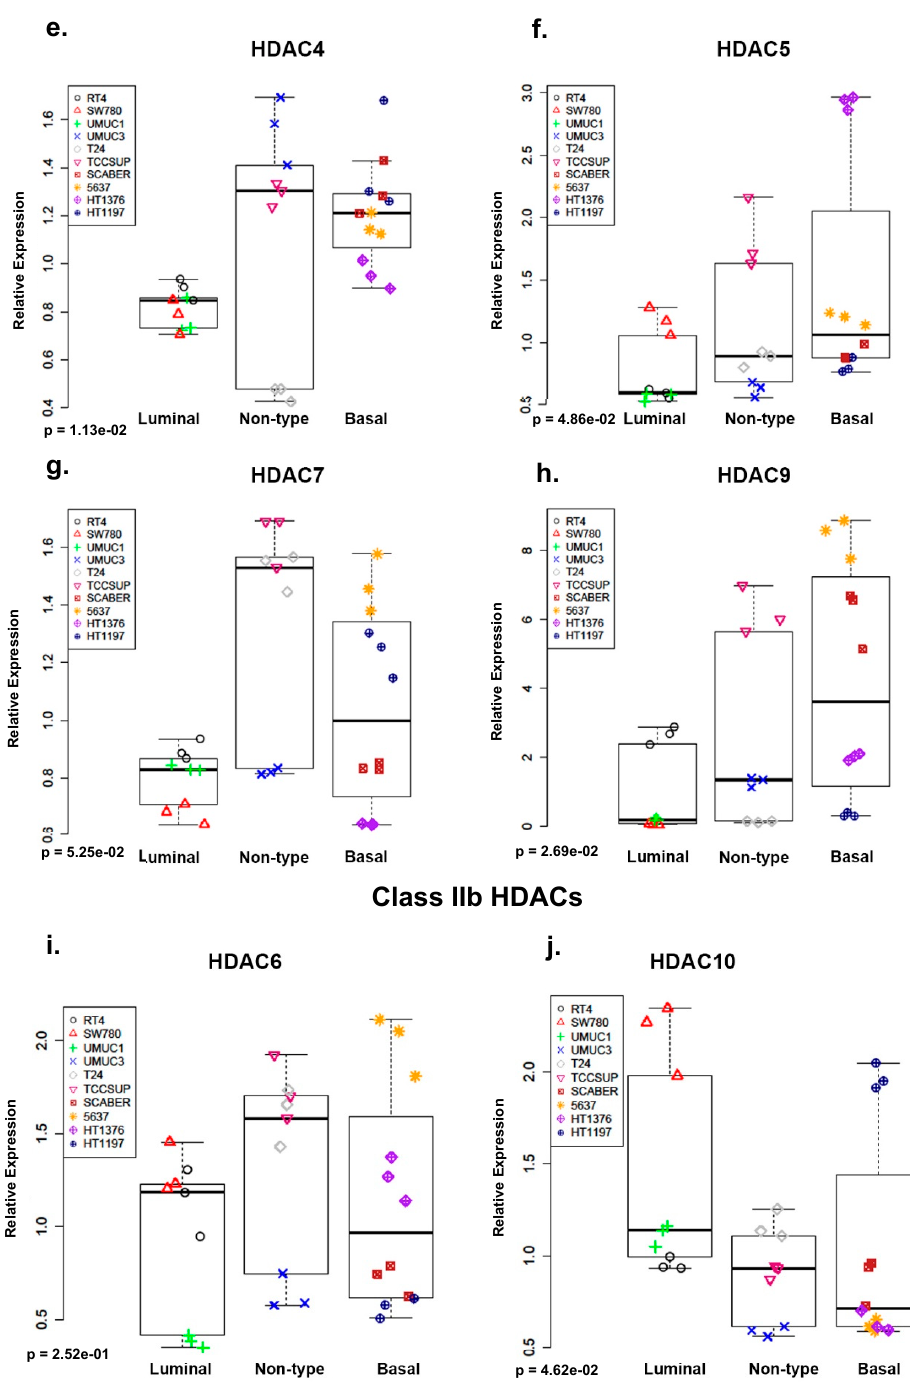
Figure 2. HDAC2 , - 3 , - 4 , - 7 , and - 9 are overexpressed in basal-squamous and non-type human BC cell lines. Boxplots depicting histone deacetylase (HDAC) expression in 10 bladder cancer (BC) cell lines (three replicates per cell line, with individual replicates depicted as one point). The cell lines are grouped based on the molecular characterization as previously described [9]. ( a – d ) Overall, class I HDAC expression increases in non-type and basal subtypes of human BC cell lines with significant di ff erences in HDAC2 and - 8 expression in human BC cell lines with non-type and basal subtypes compared to human BC cell lines with a luminal subtype. HDAC1 overexpression was observed only in human